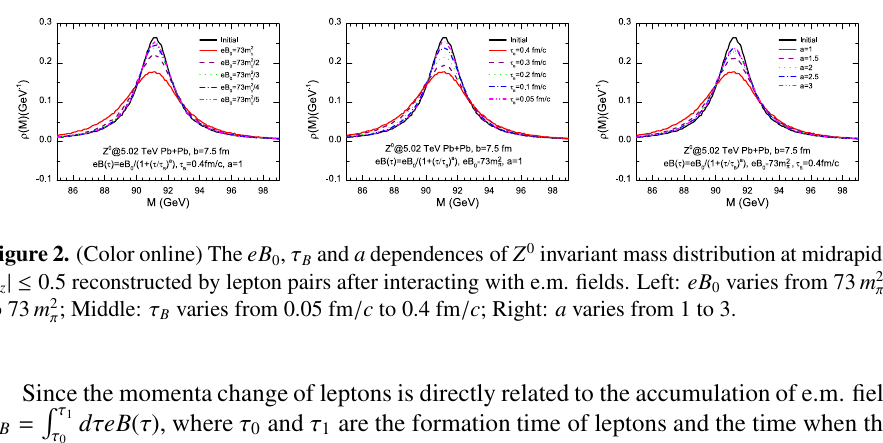
2 / 5 0 varies from 73 m π